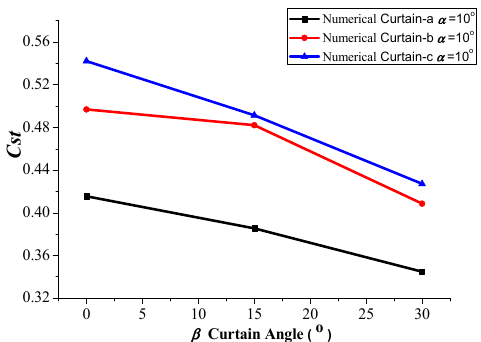
ffi cients for di ff erent curtains ( θ = 60 ◦ Figure 13. Static torque coefficients for different curtains ( θ = 60°). Figure 13. Static torque coe Figure 13. Static torque coefficients for different curtains ( θ = 60°).